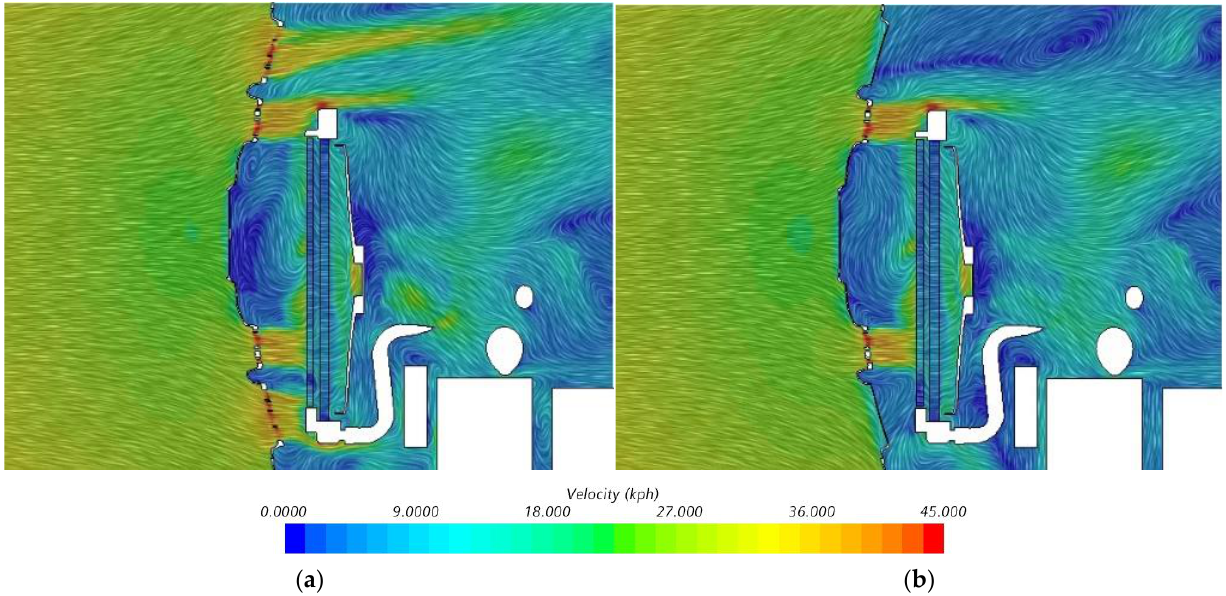
Figure 10. Comparisons of velocity fields for z = 0.44 m section between scheme 1 and original vehicle: ( a ) original vehicle; ( b ) scheme 1.